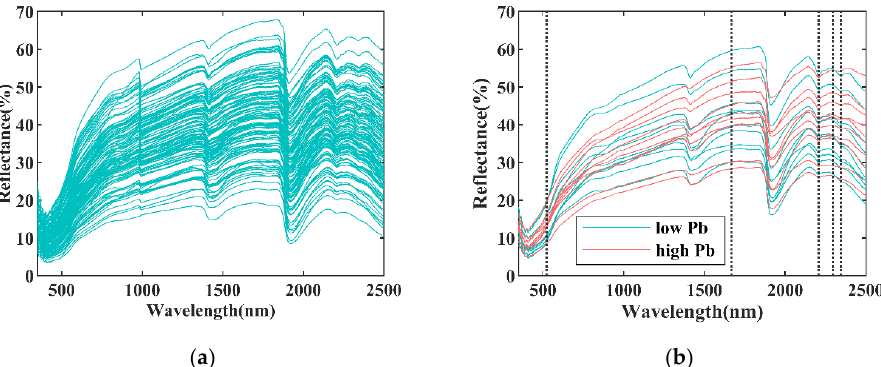
Figure 2. ( a ) Original reflectance spectra of all samples; ( b ) breakpoint corrected spectra of 20 samples with high and low Pb content (dot lines represent the selected sensitive bands of the optimized model in Section 4.2).